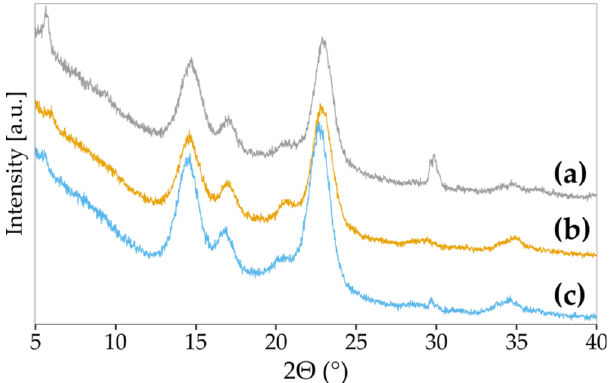
Figure 11. The FTIR-ATR spectra of BNC were produced in ( a ) SH medium supplemented with 0.5% vitamin C and ( b ) SH medium supplemented with 1.0% vitamin C.